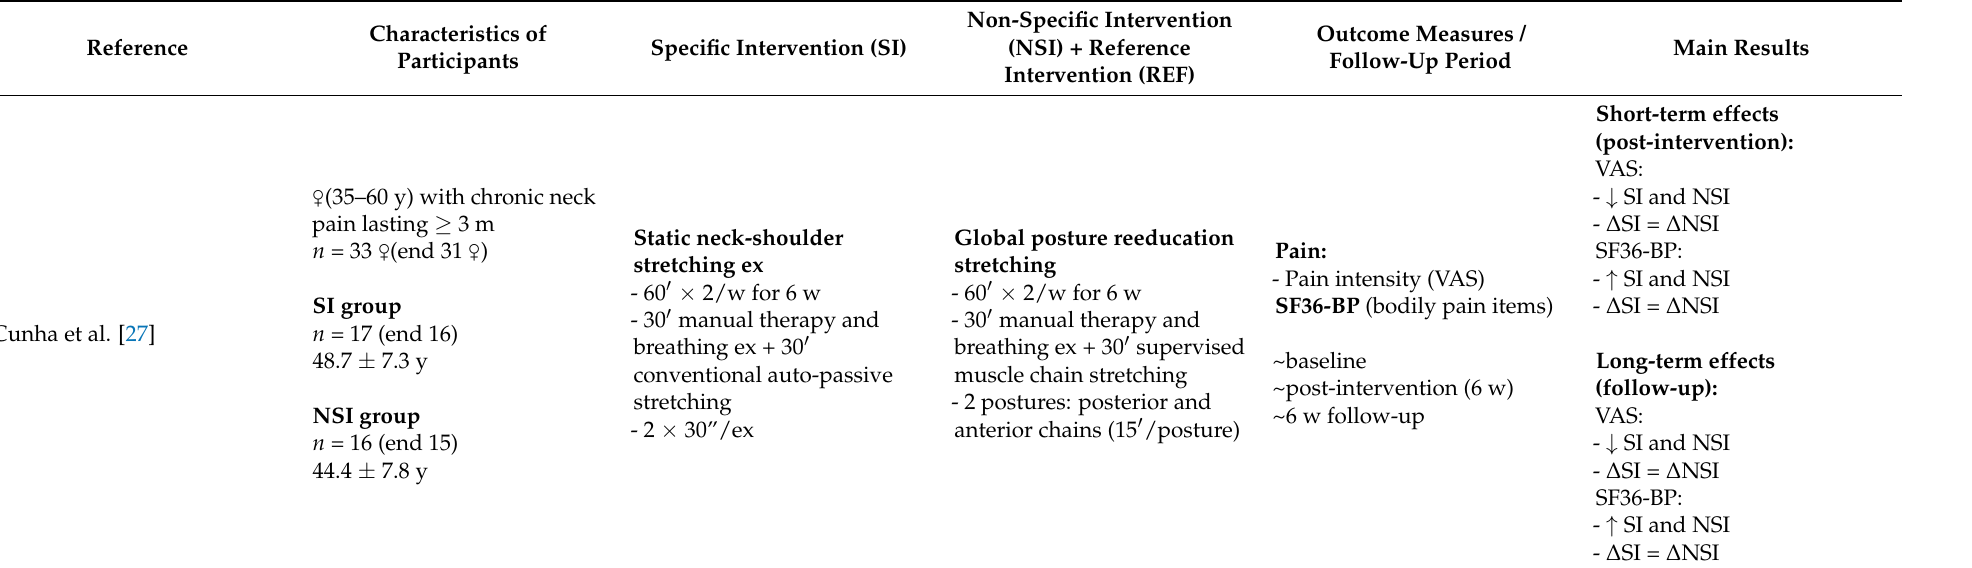
Table 5. Study characteristics. Specific stretch vs. general